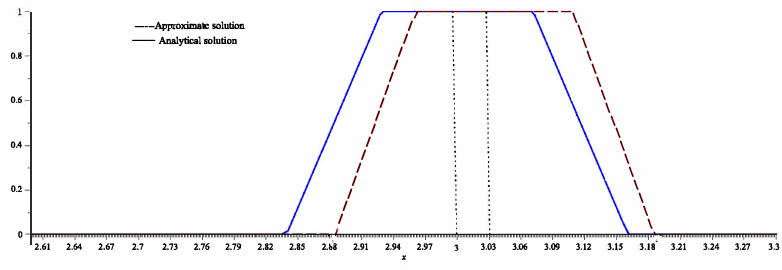
Figure 4. Approximate and analytical solutions of Example